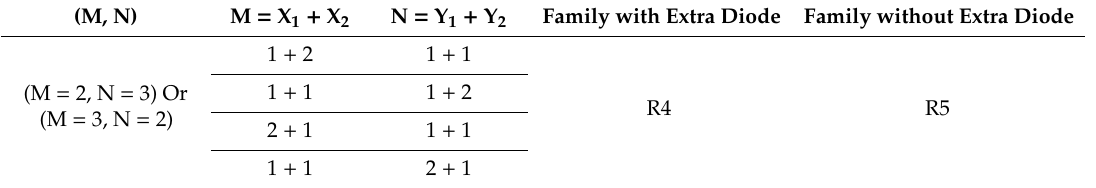
Figure 11. Two topologies derived from X 1 = 1, X 2 = 2, Y 1 = 1, and Y 2 = 1. ( a ) R4 [31]; ( b ) R5 [27]. Table 2. Topological families under M = 3 and N = 2 or M = 2 and N = 3.